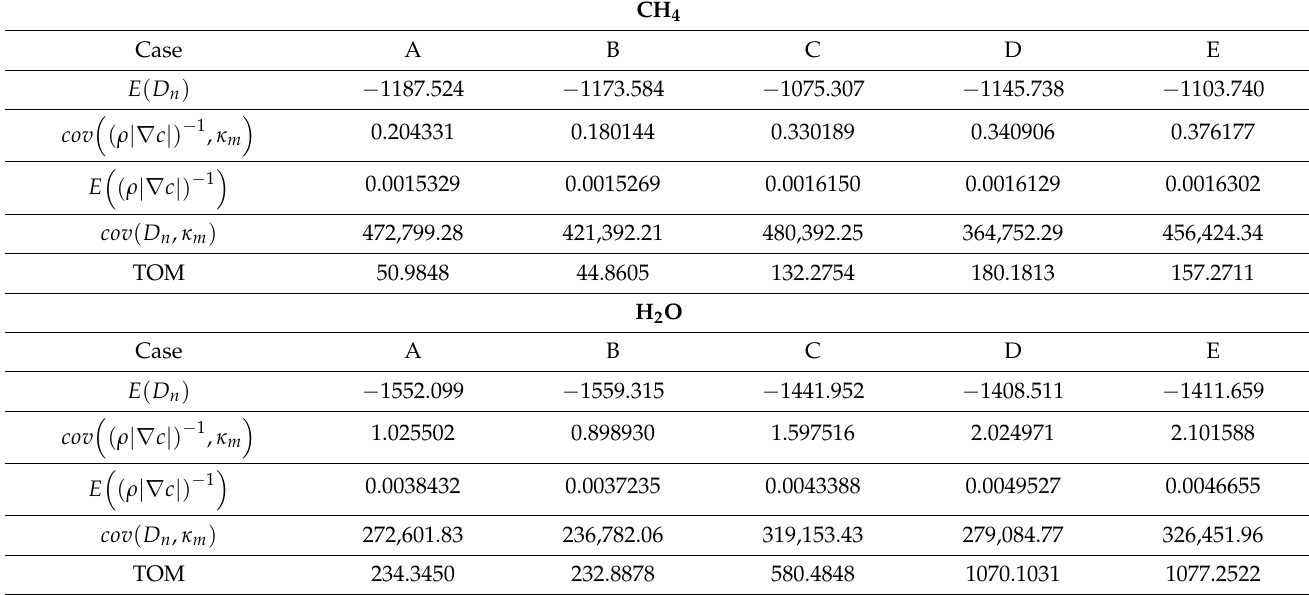
Table 15. Statistical quantities that influence the value of cov ( S n , κ m ) (see Equation (12)) for the c = 0.8 isosurfaces for all cases and reaction progress variable based on CH 4 and H 2 O mass fractions. The normal diffusion contribution is → → N . ∇ ( ρ D c N . ∇ c ) abbreviated as D n =